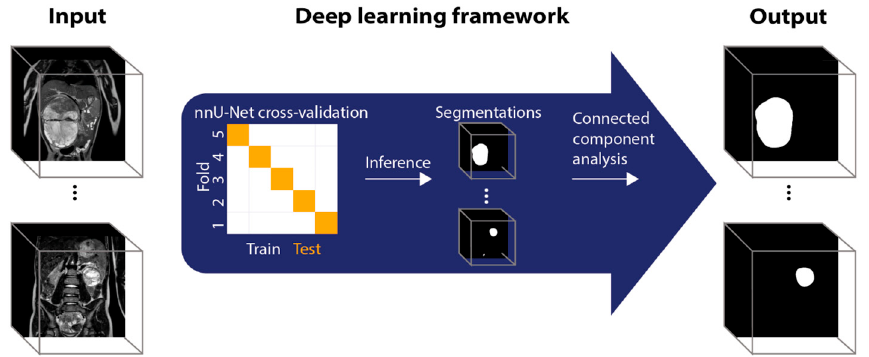
Figure 1. Schematic overview of the deep learning image analysis workflow. All analyses are performed in 3D. Images in the figure are 2D schematic representations of 3D volumes.